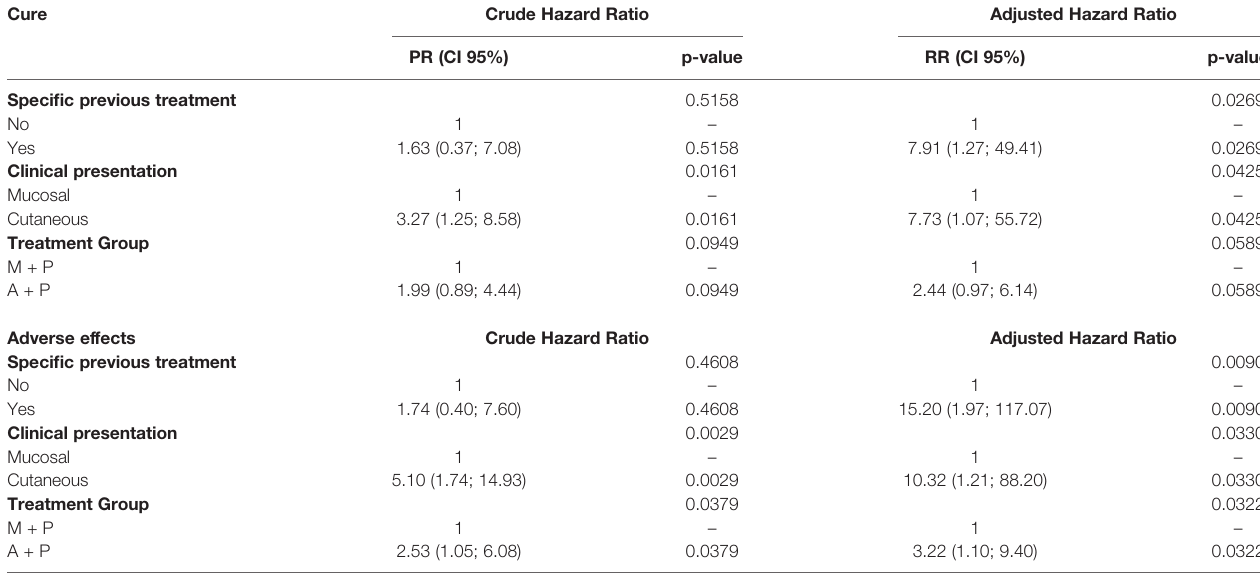
TABLE 2 | Multivariate analysis results showing hazard ratios for cure and adverse effects in patients treated with miltefosine and pentoxifylline and in patients treated with pentavalent antimonial and pentoxifylline.